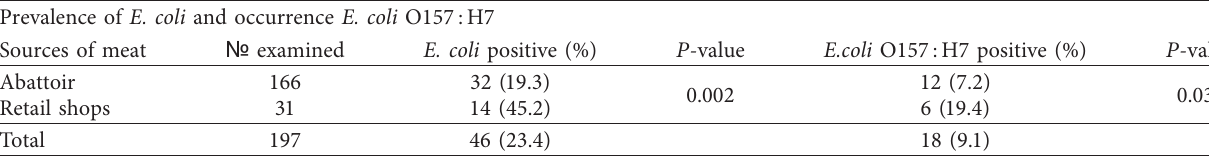
Table 1: Prevalence of E. coli and occurrence of E. coli O157: H7 in beef from abattoir and retail shops in Ambo, West Shewa, Ethiopia (January 2016 to May 2017). Prevalence of E. coli and occurrence E. coli O157 :H7